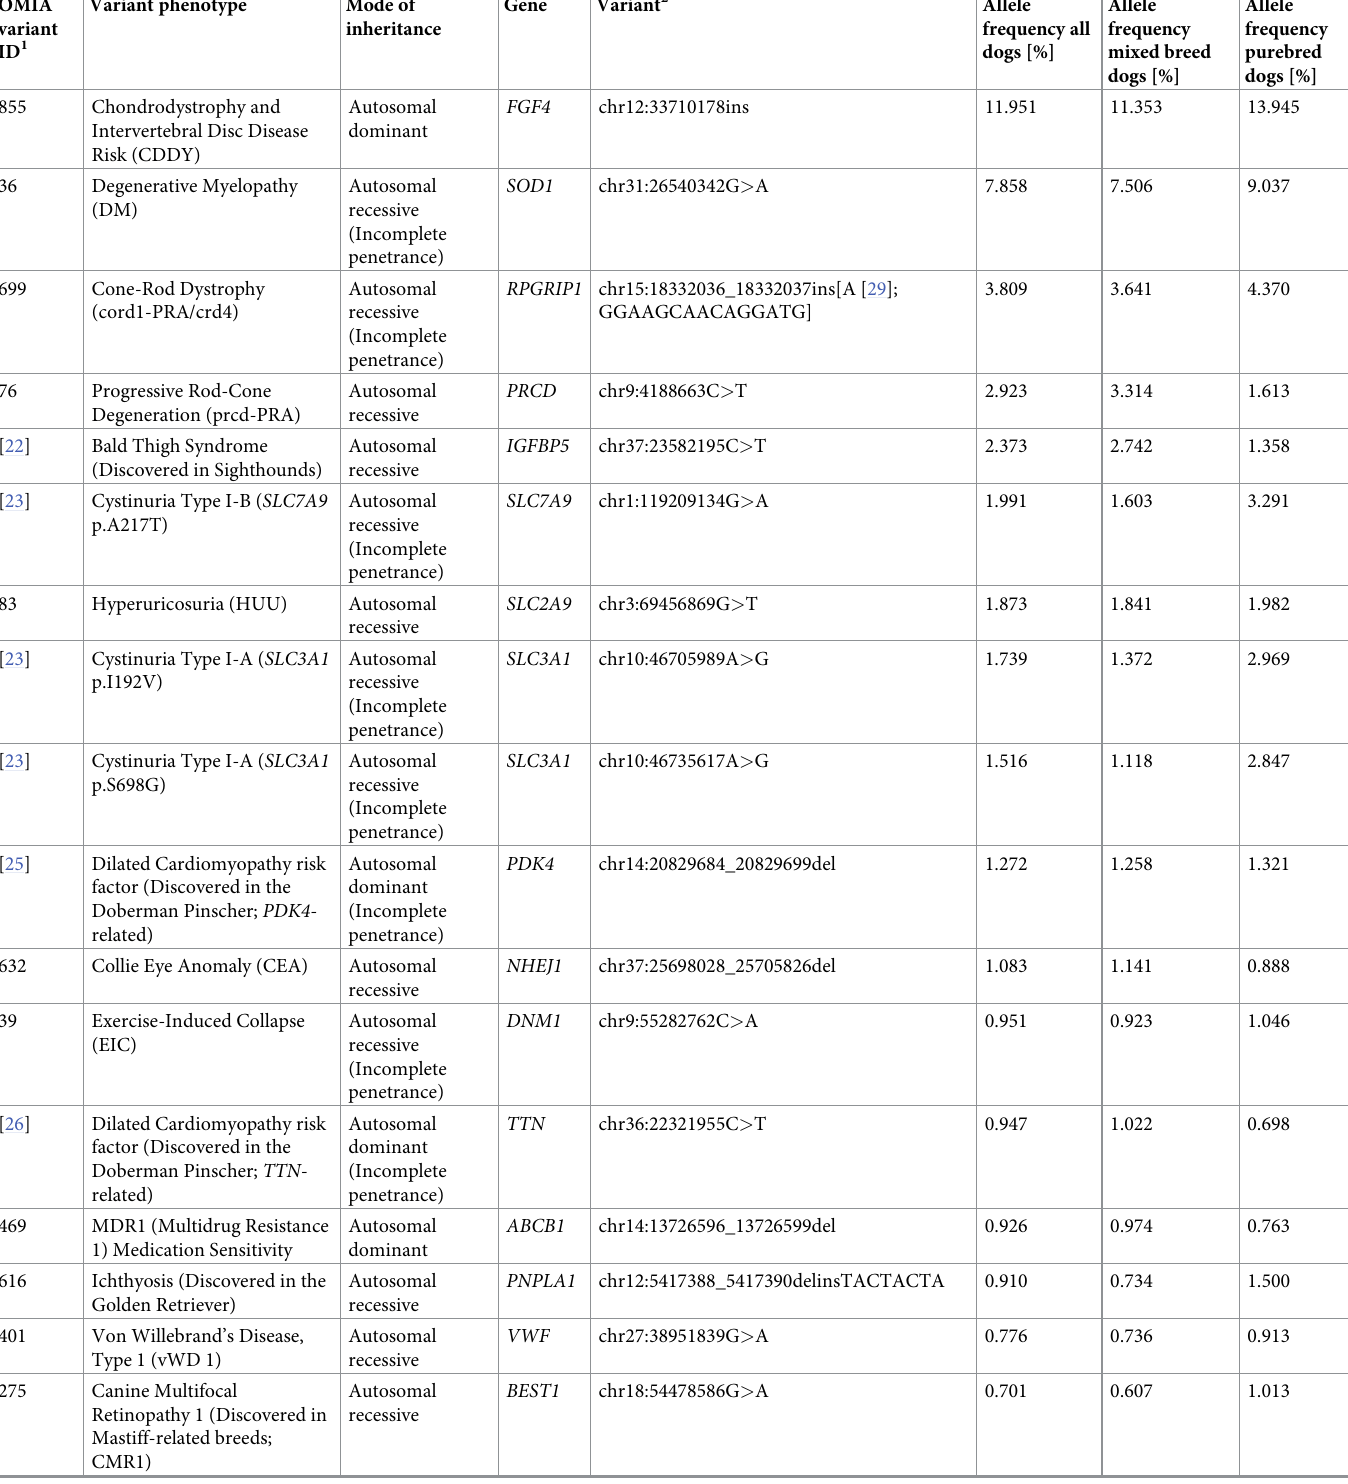
Table 1. Putative disease-associated variants with allele frequency > 0.5% in the examined canine